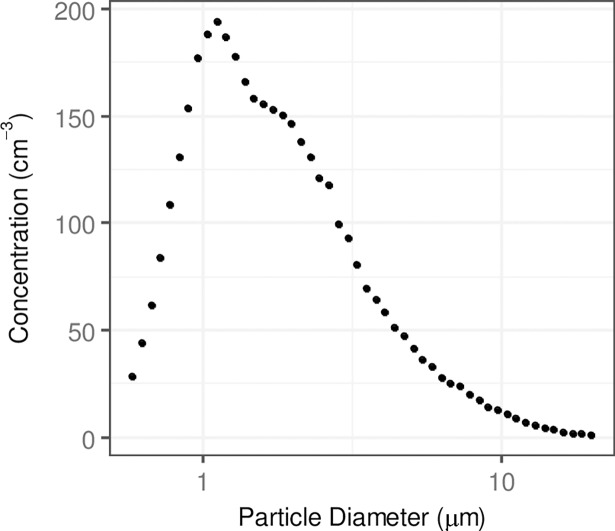
Total particle number size distribution of concrete dust particles as measured by the APS.The respective number size distributions were aggregated to the total size distribution.